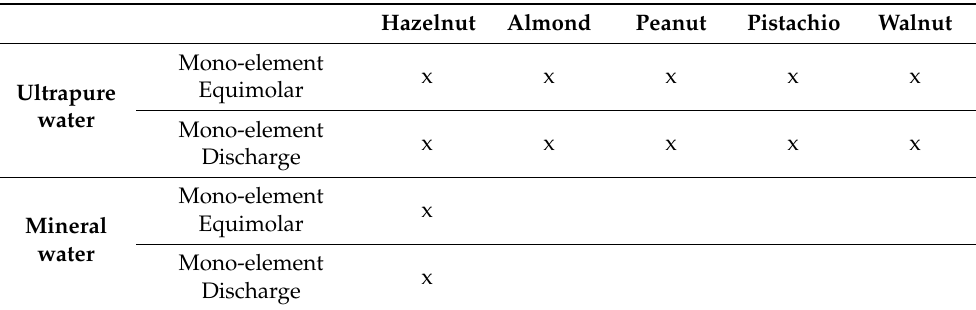
Table 1. Experimental conditions of the conducted biosorption